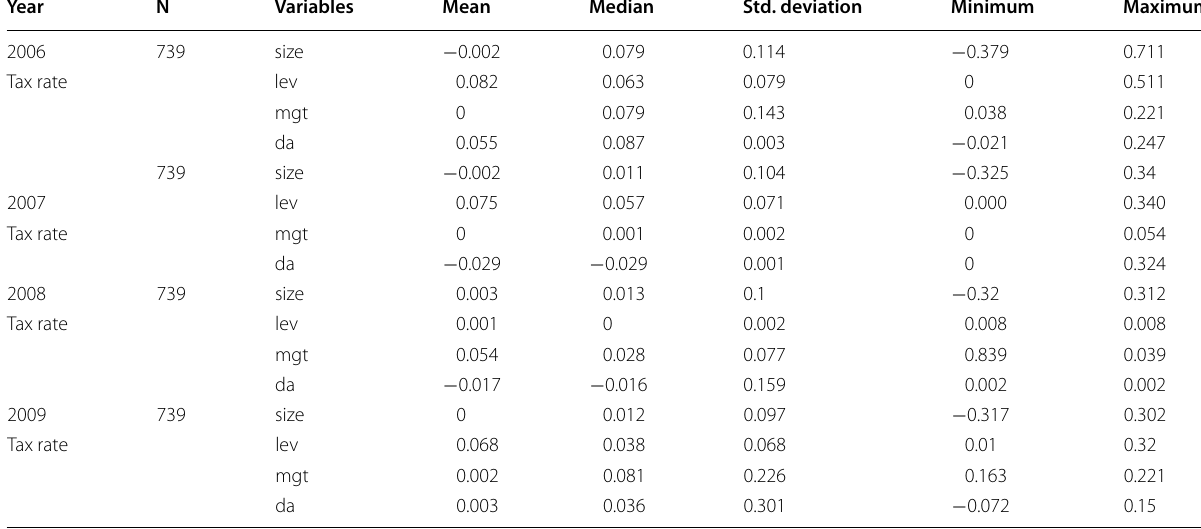
Table 6 Correlation coefficient between variables-Dutch Co